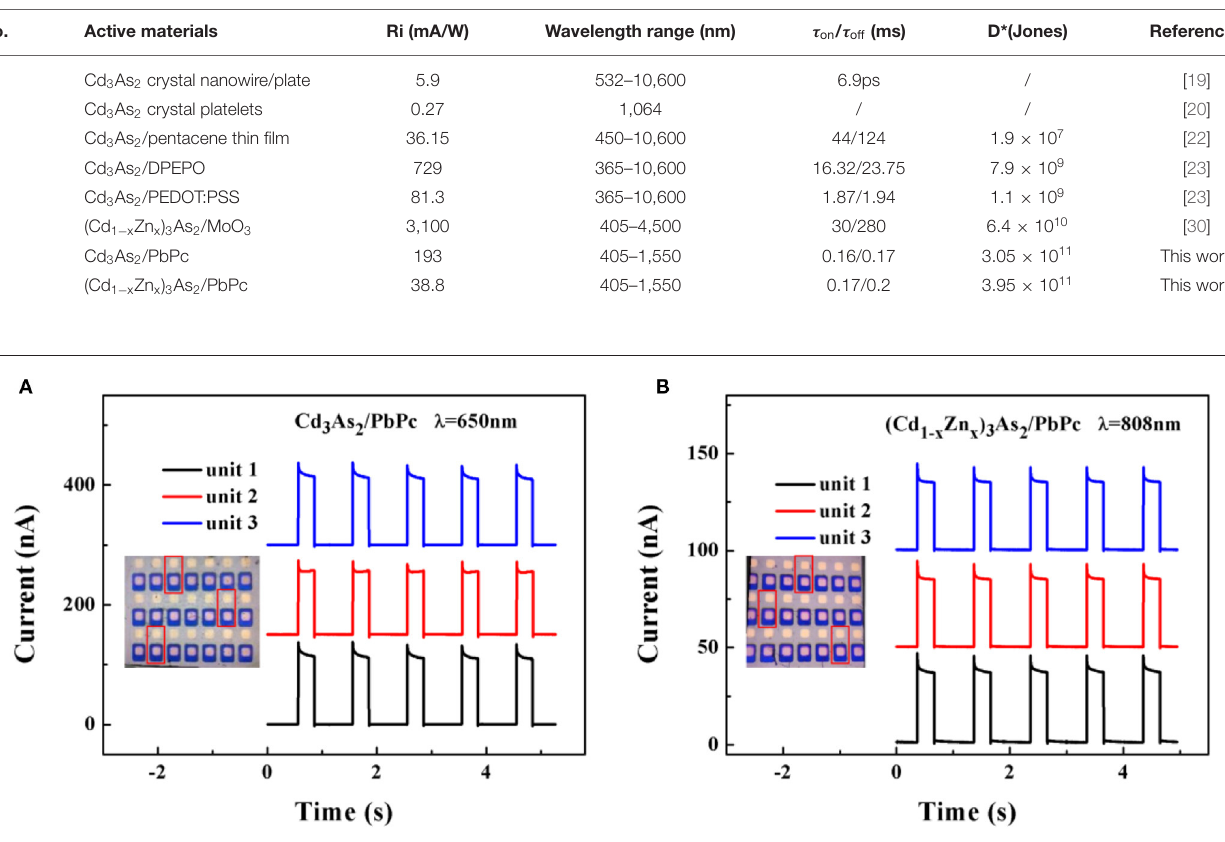
FIGURE 5 | (A,B) Three different unit photocurrent diagrams of DSM/PbPc thin film heterojunction array devices, respectively. Under bias voltage of power intensity of 2 mW/cm 2 . The illustration is the physical picture of the array device, the parts selected in the red frame are the unit